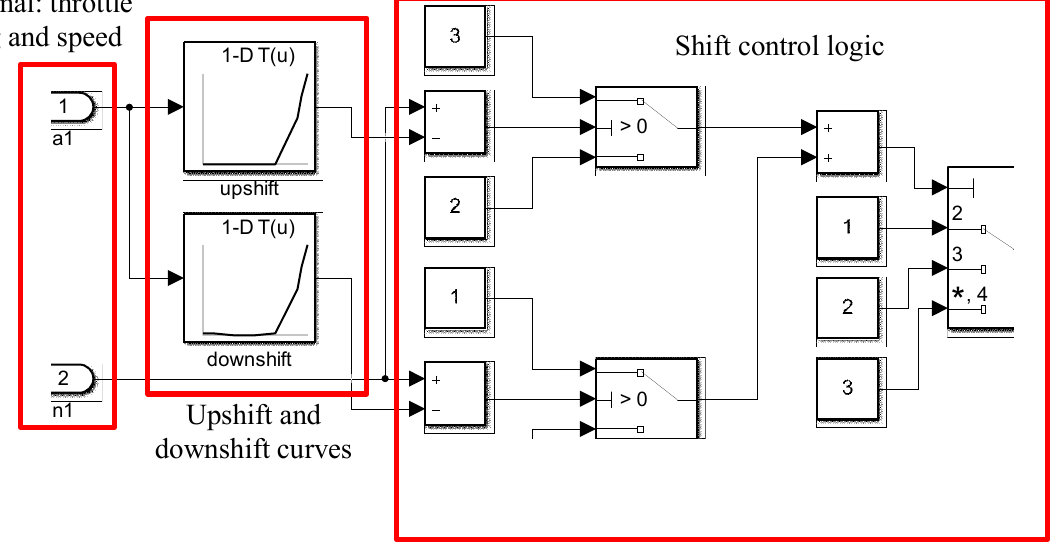
Figure 7. A transmission ratio control strategy subsystem of SAT.